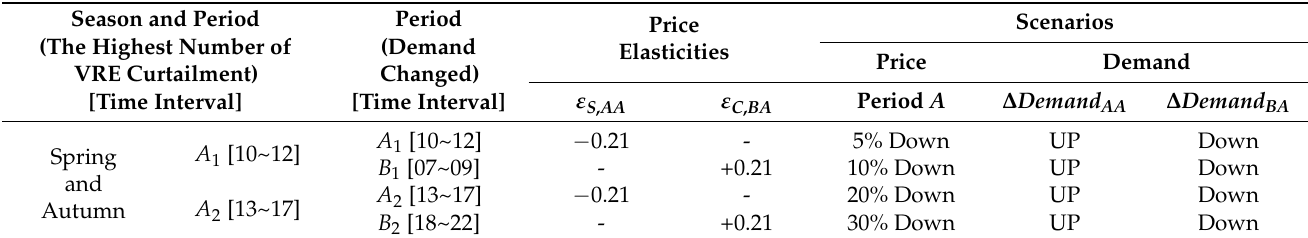
Table 11. The composition of scenarios for applying the revised ToU tariff rates.